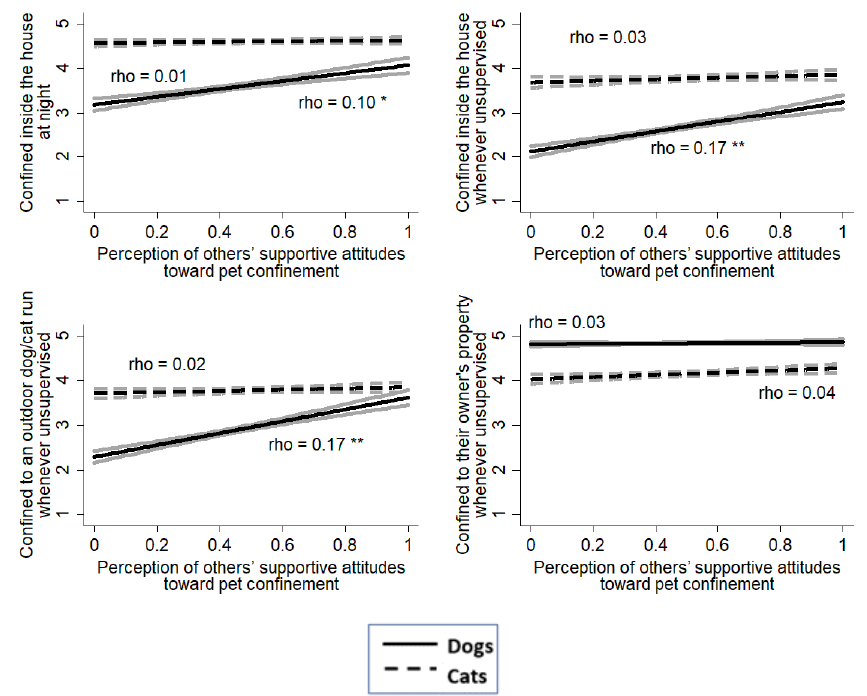
Figure A3. Bivariate associations between perception of others’ attitudes and individual items on pet confinement, separately for dogs (in 1291 dog owners) and cats (in 1146 cat owners); Spearman’s correlation coefficients (rho) are presented for each line with significance level denoted by the asterisk (* p < 0.05, ** p < 0.01).